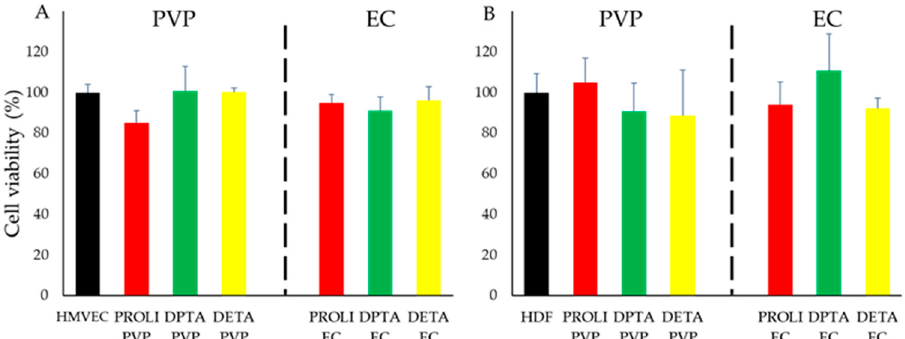
Figure 5. In vitro evaluation of the cytotoxic effect of NO-fibers on HMVEC and HDF cells. Cell viability was measured using alamarBlue assay after 24 h of incubation with PVP and EC NO-fibers. ( A ) Percent viability of HMVEC with respect to untreated HMVEC; ( B ) percent viability of HDF with respect to untreated HDF. Data are shown as mean ± SD.